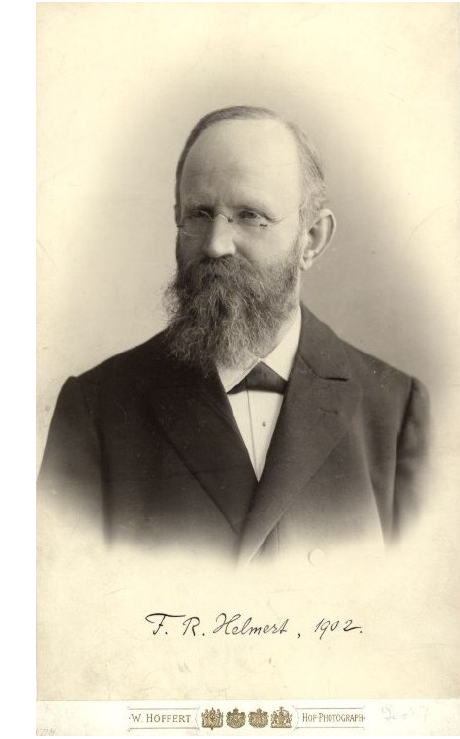
Figure 1. Friedrich Robert Helmert (Humboldt University